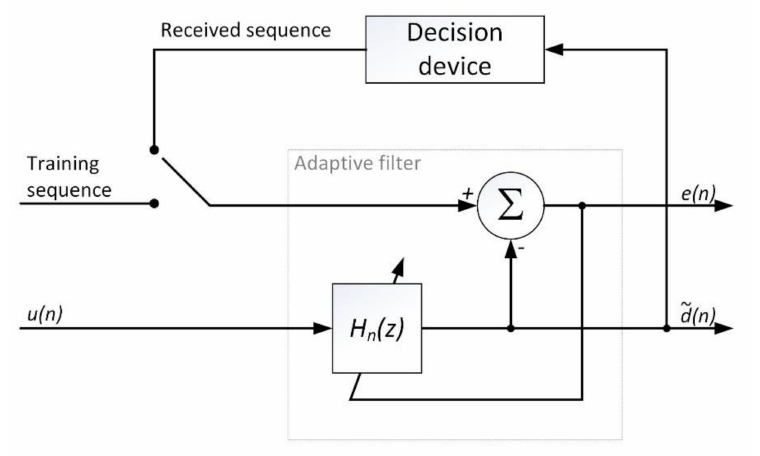
Figure 2. Adaptive channel correction